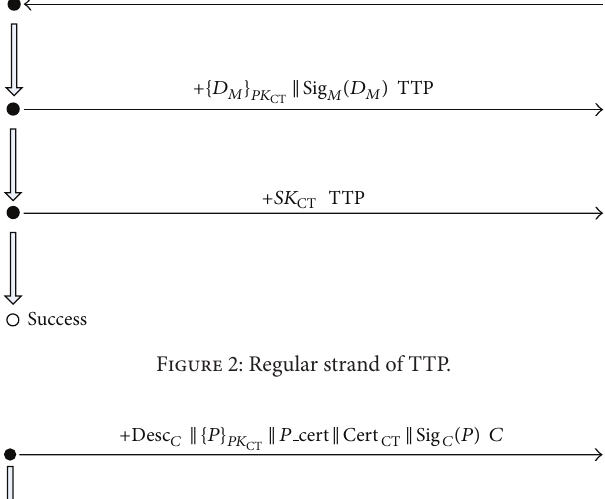
strands directly. Figure 2 is a regular strand of